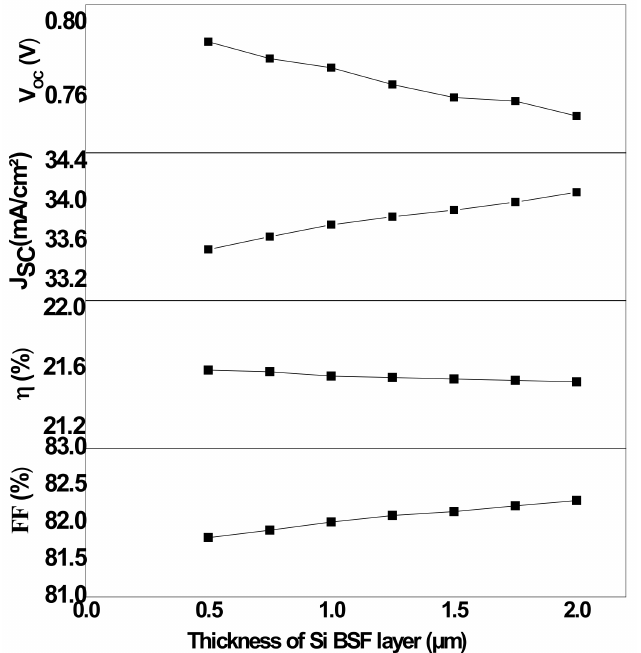
Figure 6. The performance of the solar cell with BSF as a function of Si BSF layer